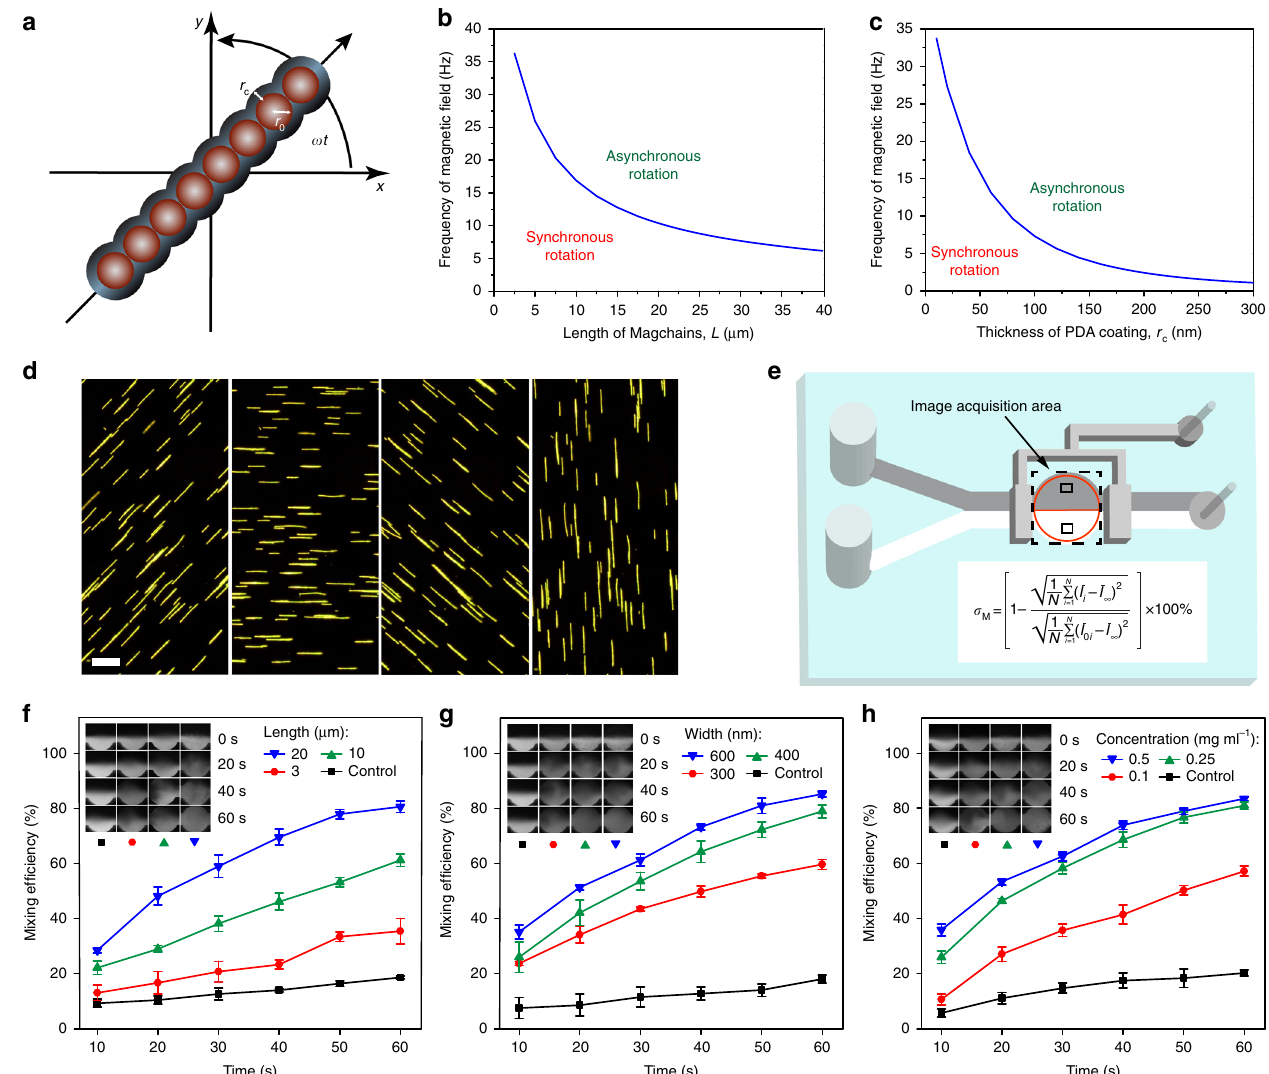
Fig. 2 Mixing enhancement by magnetic nanochains. a Force analysis of a magnetic nanochain in a rotating external magnetic fi eld. r 0 and r c are the radius of magnetic nanoparticles and the thickness of polydopamine (PDA) layer, respectively. b , c Theoretical analysis results of maximum frequency ( f max ) to maintain synchronous rotation of the magnetic nanochains with different length ( b ) and PDA thickness ( c ). d Dark- fi eld microscope images of magnetic nanochains responding to an alternating magnetic fi eld, captured by a CCD camera. Scale bar: 20 µ m. e Schematic of micro fl uidic chip for the evaluation of mixing ef fi ciency. Inset: equation for evaluation of the mixing ef fi ciency based on fl uorescence distribution. f – h Mixing enhancement by using magnetic chains of different lengths ( f ), widths ( g ), and concentrations ( h ). The insets are the respective images of acquisition area at 0, 20, 40, and 60 s. Error bars indicate the standard deviation of three